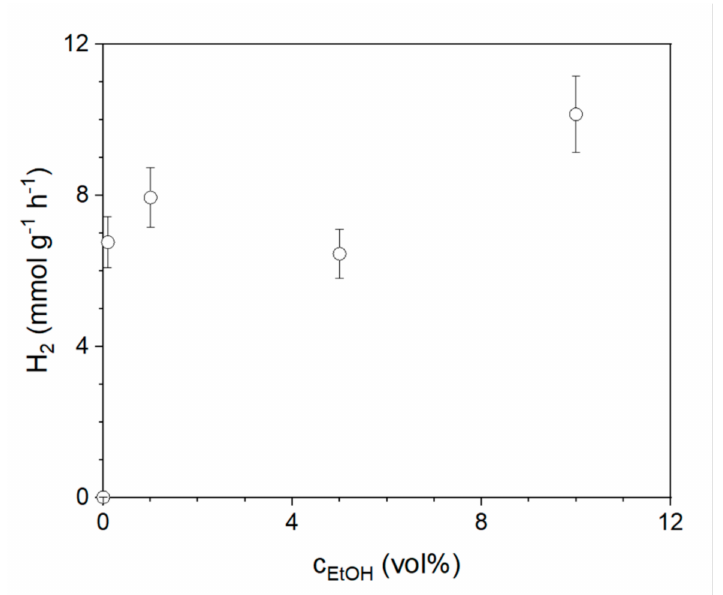
Figure 6. Hydrogen productivity with Pt MS @PC500 (c Pt@PC500 = 0.5 g L − 1 , 0.37 wt.% Pt, T = 30 ◦ C, t = 2 h, 300 W Xe lamp (full spectrum)) for different ethanol concentrations ( ±